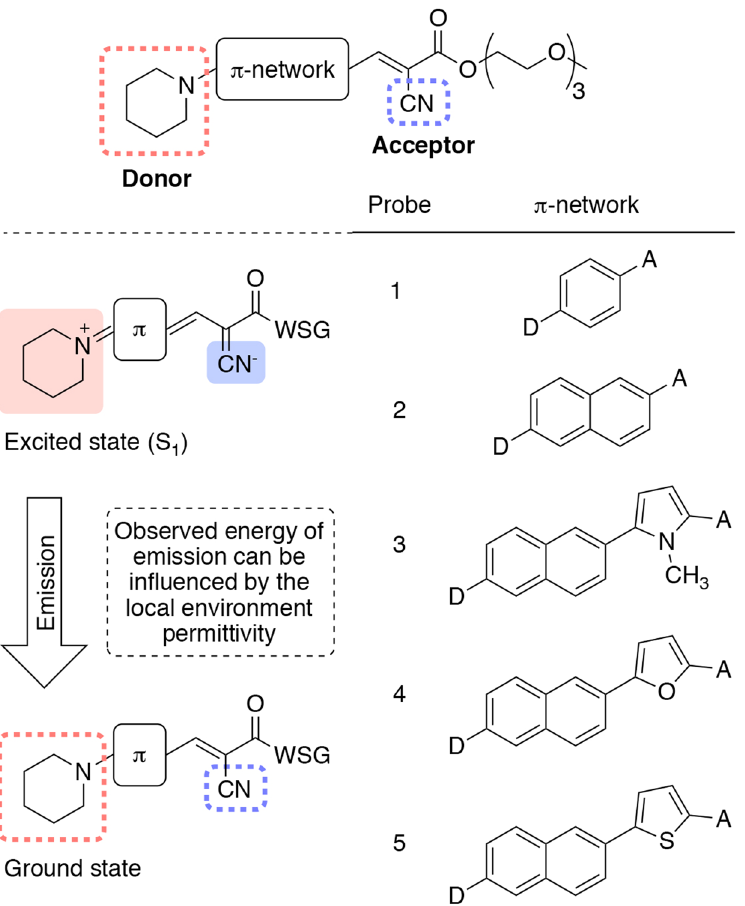
Figure 2. Structure of amino-aryl cyanoacrylate (AACA) fluorophores and the proposed mechanism of environment sensitivity. WSG = water solubilizing